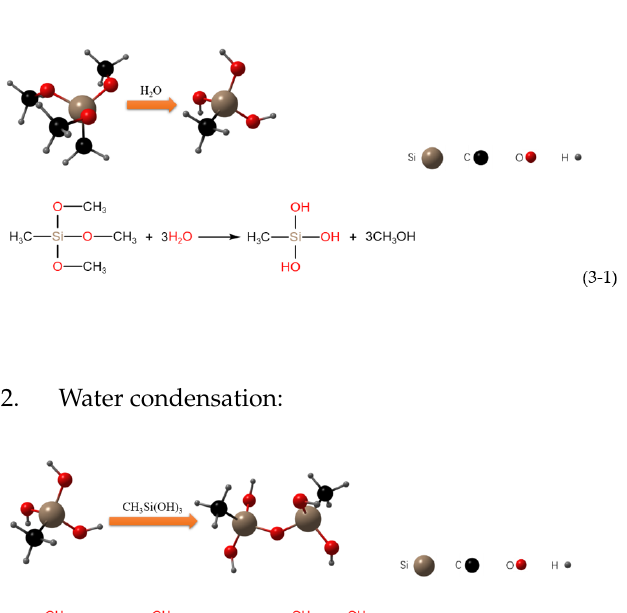
Figure 8. Schematic diagram of isolated silanol, geminal silanol, and vicinal silanol. The three hydrolyzed methoxyl groups of the MTMS monomer are hydrolyzed and polymerized in a three-step reaction [51], as shown in the following reaction: